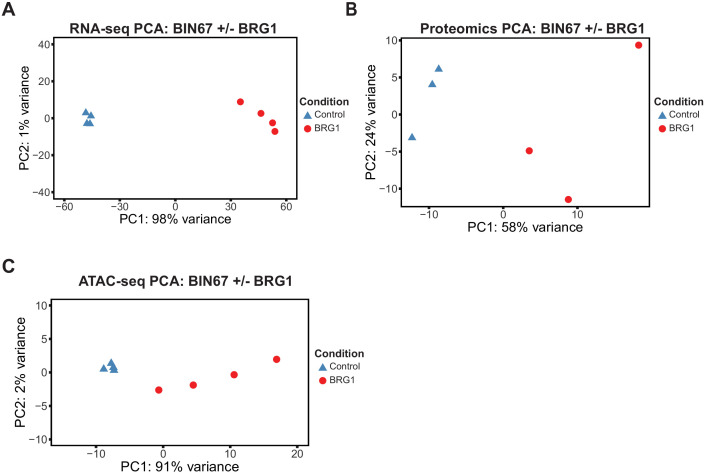
Unsupervised analysis for multi-omics samples.Principal component analysis (PCA) for RNA-seq (A), Proteomics (B), ATAC-seq (C). A, PCA for RNA-seq samples was performed by DESeq2 on rlog transformed counts. (B) PCA was performed by prcomp on log2 transformed counts for proteomics samples. (C) PCA was performed on rlog transformed counts under called ATAC-seq peaks by DESeq2.